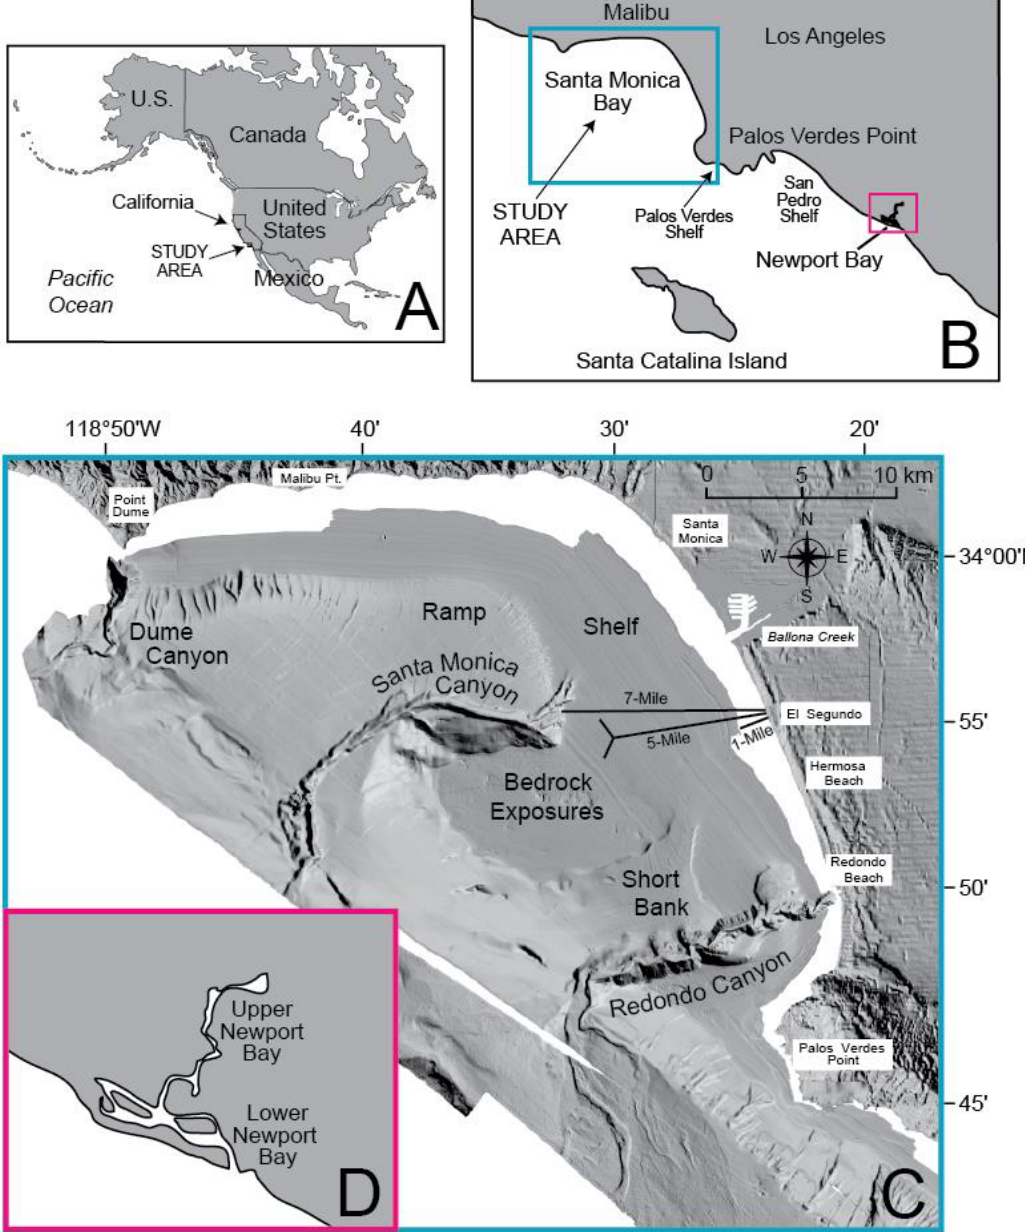
Figure 1. ( A ). Location of the study area off southern California on the west coast of the United States. ( B ). Detail of the study area of Santa Monica Bay (blue rectangle) off the city of Los Angeles, and Newport Bay (red rectangle), the source of the amphipods used in the macrofaunal toxicity testing of this study. ( C ). Side-scan sonar image of Santa Monica Bay, showing the location of the shelf, bedrock exposures, ramp, Short Bank, Santa Monica and Redondo Canyons, and the 7-Mile, 5-Mile, and 1-Mile outfalls. ( D ). Detail of Newport Bay, including Upper Newport Bay where the amphipods were